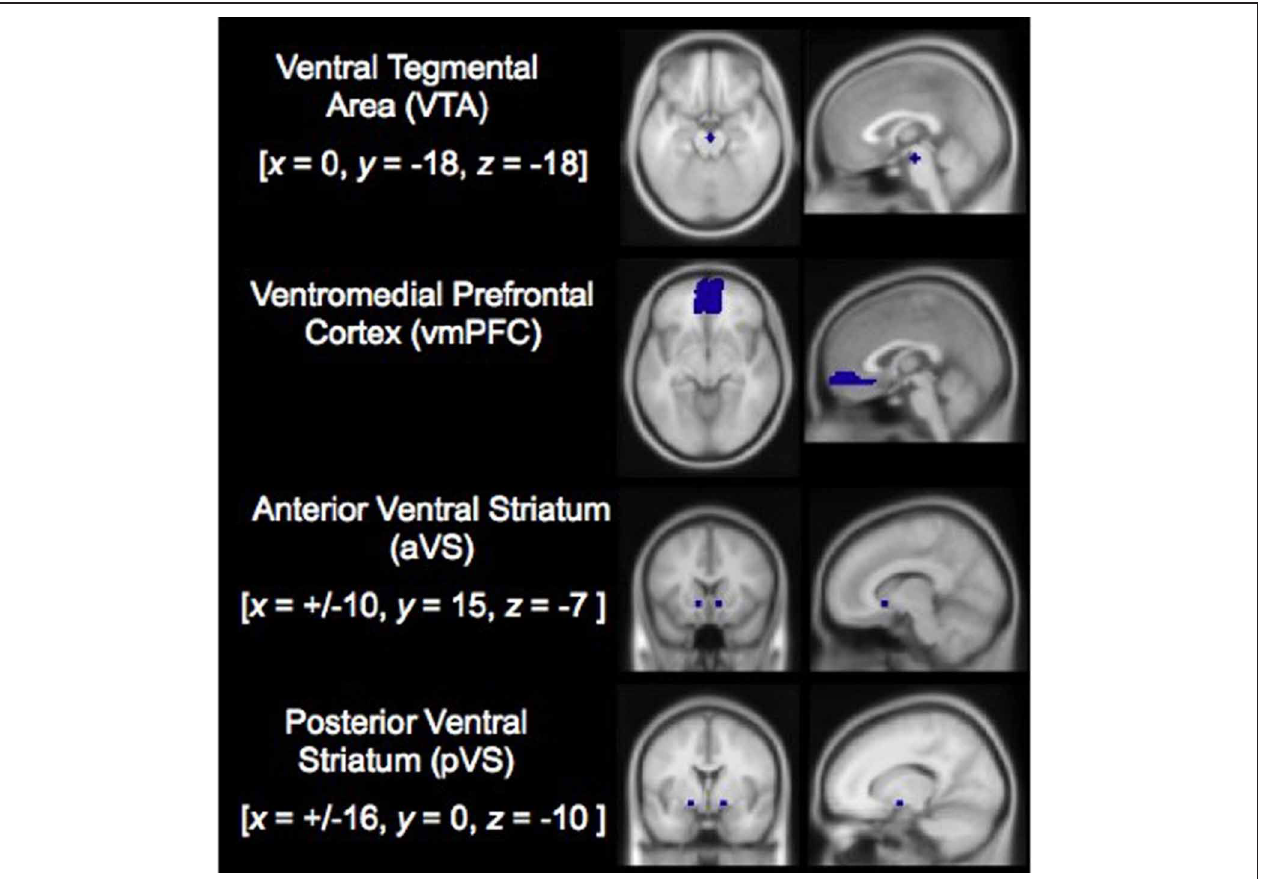
FIGURE 2 | Independent, a priori defined regions of interest used in analyses. Note: x , y , and z refer to MNI coordinates indicating the centers of mass for each ROI in left-right, anterior-posterior, and superior-inferior dimensions.